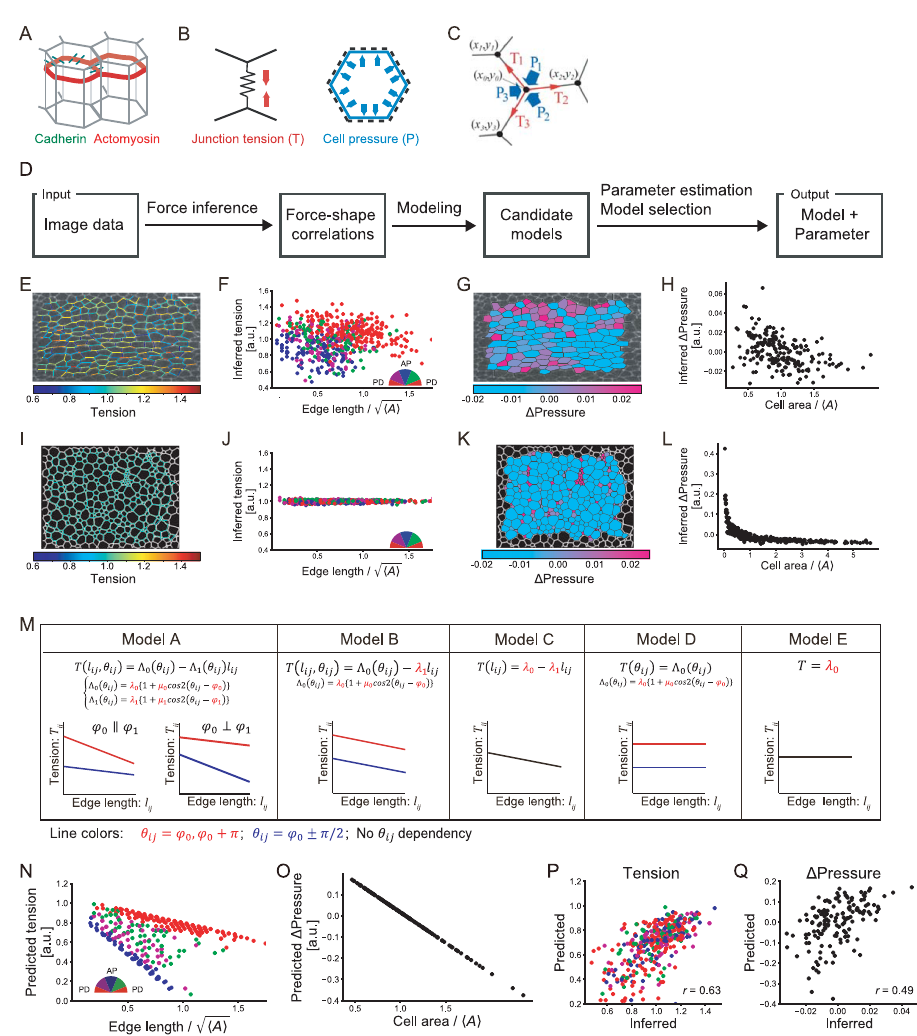
Fig 1. Image-based parameter estimation for epithelial mechanics. (A) The structure of the monolayer epithelium. Epithelial cells adhere to each other via cell adhesion molecules such as cadherin (green). Actomyosin cables (red) run along the cell cortex in the plane of the adherens junction (AJ). (B) Forces acting along the AJ plane. Left: Junction tension. Right: Cell pressure. (C) Balance of tensions (T) and pressures (P) at a cell vertex indicated by a black dot. (D) Flowchart of the proposed method to estimate mechanical parameters from image data, in which cell contour is visualized. (E–L) Force-shape correlations obtained by Bayesian force/stress inference in epithelial tissue (E–H) and in foam (I–L). Bayesian force/stress inference yields maps of junction tension (E, I) and cell pressure (G, K), which are overlaid on input images (epithelial tissue: DE-cad-GFP in Drosophila pupal wing at 22 h APF, foam: a coarsening foam [73]). Each junction is classified by its orientation relative to the horizontal axis (semicircle; PD: proximal-distal and AP: anterior-posterior), and its inferred tension is plotted against its length (F, J). The inferred pressure is plotted against the cell/foam area (H, L). h A i represents the average cell area. (M) Table of a series of models, which are designated model A to model E in order of decreasing complexity. A schematic showing the dependence of tension on junction length and orientation and the tension function is shown for each model. Parameters are indicated in red. (N–Q) Results of parameter estimation from the Drosophila wing image shown in E. (N) The orientation of each junction relative to the PD axis of the wing is classified (semicircle), and its tension predicted from estimated parameters is plotted against its length. (O) Cell pressure predicted from estimated parameters is plotted against cell area. (P, Q) Correlation between predicted force values obtained by the parameter estimation method and inferred force values obtained by Bayesian force/stress inference. Predicted tensions and pressures (vertical axis) are plotted against inferred tensions and pressures (horizontal axis), respectively. The correlation coefficient is shown in the bottom right corner. Scale bar: 10 μ m in (E).